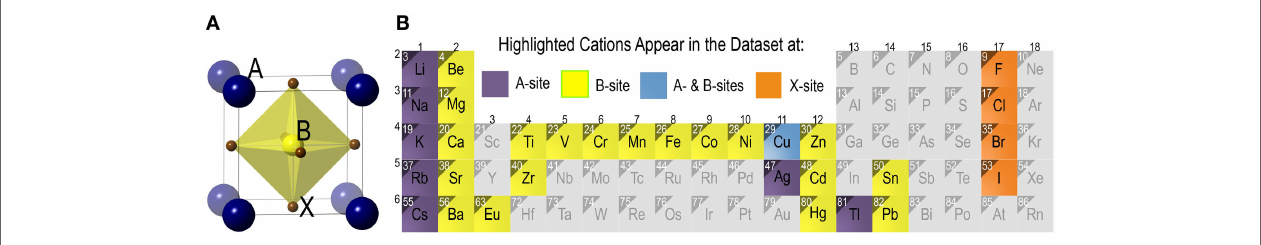
FIGURE 1 | (A) The prototypical cubic perovskite halide crystal structure of ABX 3 compounds with corner sharing octahedra of halide anions (X) housing B-site cations. A-site cations occupy a 12-fold coordination site surrounding BX 6 octahedra (shown explicitly in the figure). (B) Chemical space of the ABX 3 halide chemistries explored in the present study. Cations appearing at the A-site and/or the B-site are highlighted. X site can be occupied by four halides in group 17.